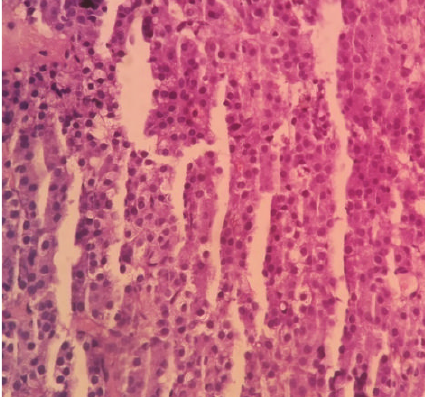
Figure 2: Atypical cells arranged in 1-2 layers of trabeculae sepa- rated by sinusoids. Individual cells are having round nucleoli with moderate granular